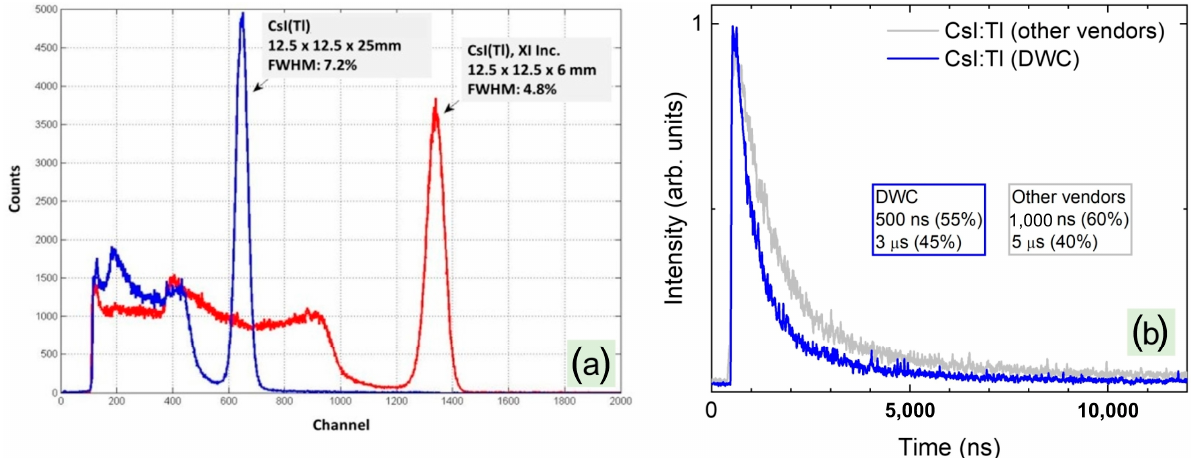
Figure 3. ( a ) 137 Cs spectra collected by an improved 12.5 × 12.5 × 6 mm 3 CsI:Tl grown and developed by XI, Inc. (red) and by a commercially available 12.5 × 12.5 × 25 mm 3 CsI:Tl crystal (blue). ( b ) Decay time profile.